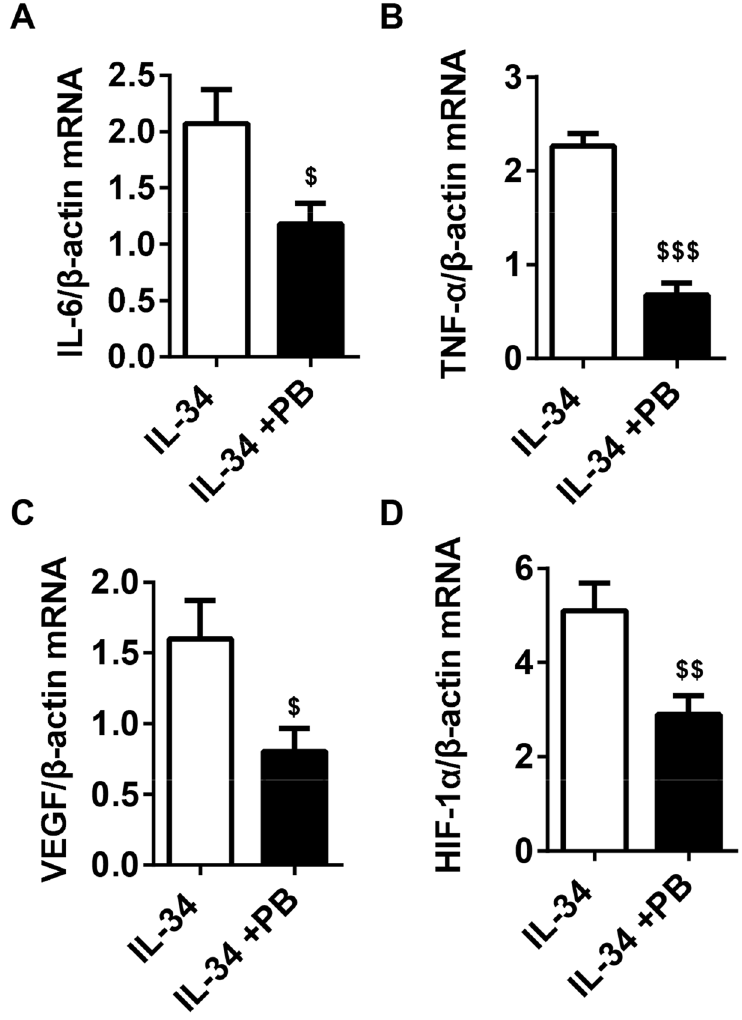
Figure 4. PB antagonized the effect of IL-34 on the mRNA expression of IL-6, TNF-α, VEGF, and HIF-1α in RA-FLSs. ( A–D ) RT-PCR analysis to determine IL-6, TNF-α, VEGF and HIF-1α mRNA levels in RA-FLSs after treatment with IL-34 (100 ng/ml) and IL-34 (100 ng/ml) + PB (4 µM). The differences between two groups were tested by two-tailed Student’s t-tests. The data are expressed as the mean ± SEM. $ P < 0.05, $$ P < 0.01, $$$ P < 0.001 vs the IL-34